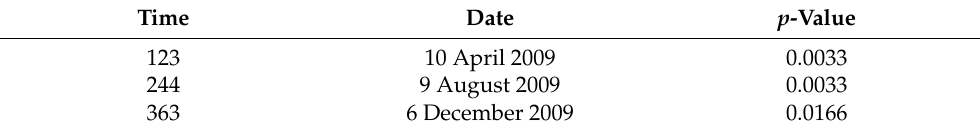
Table 4. Estimated change points for the time series with hate speech along with the corresponding significance